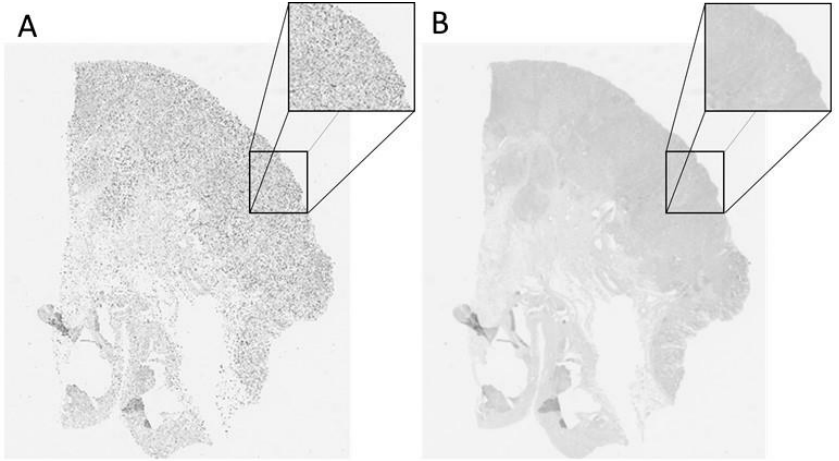
Figure 4. Gastric image resampled before ( A ) and after ( B ) smoothing with a Gaussian kernel.